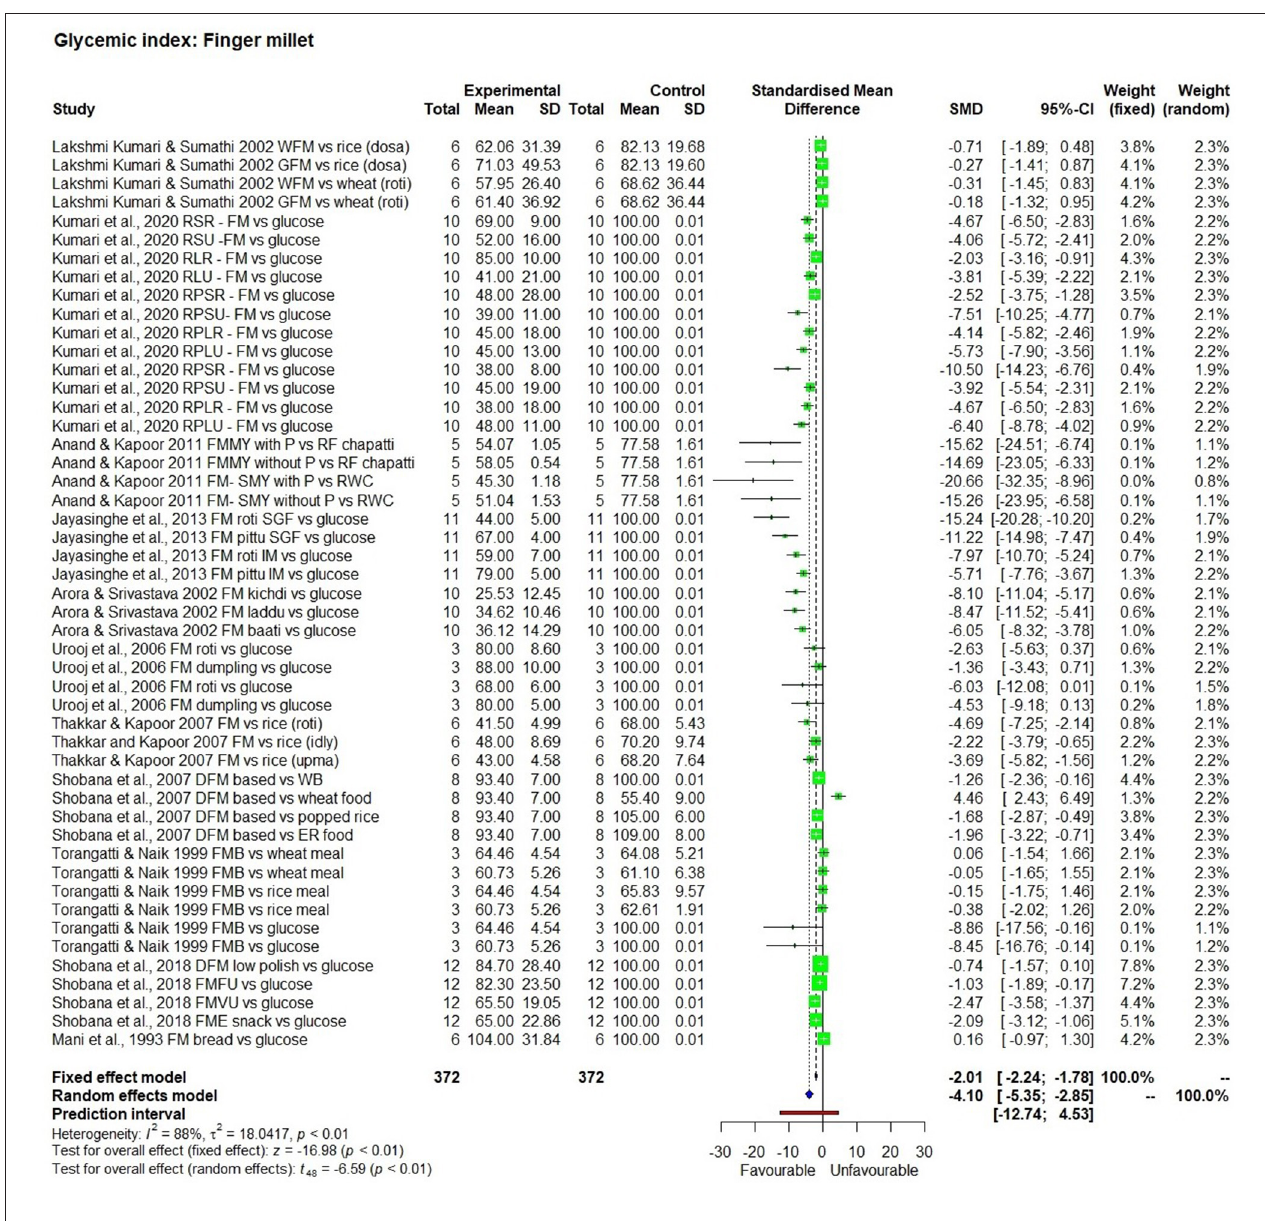
FIGURE 3 | The Glycaemic Index of a finger millet diet compared to control samples.